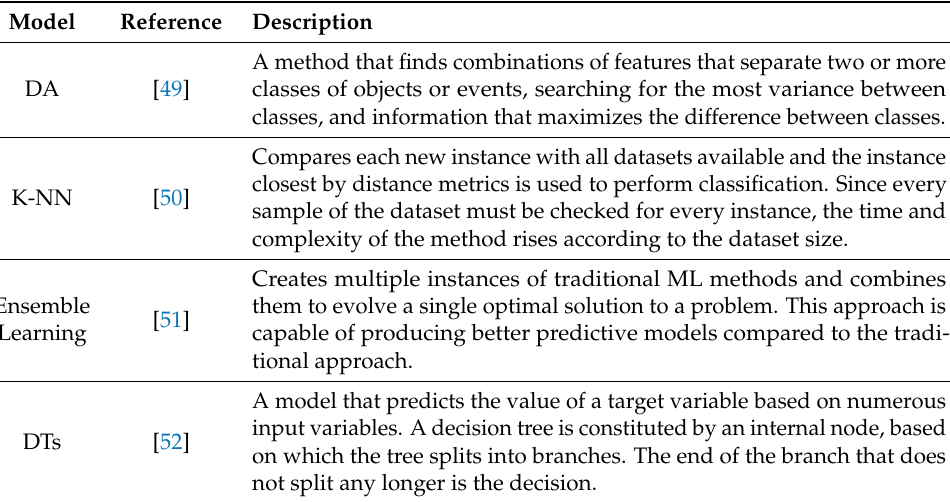
Table 6. Machine Learning models evaluated in this work and respective